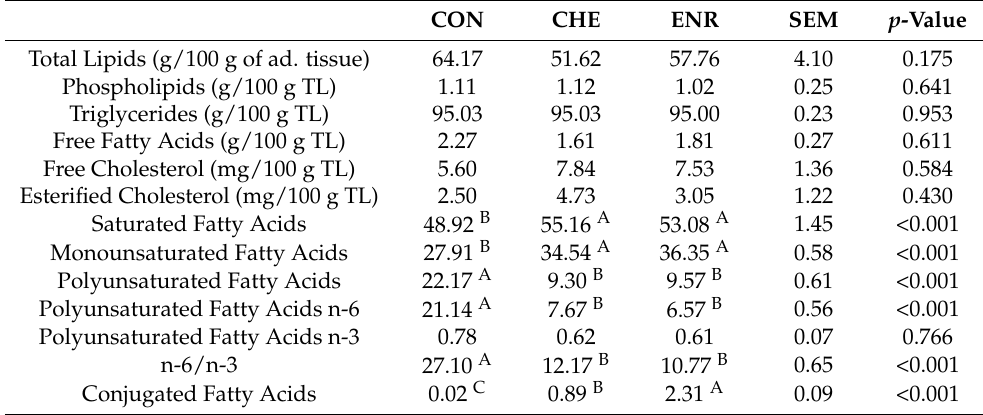
Table 6. Effect of the diet on the lipid profile of adipose tissue.